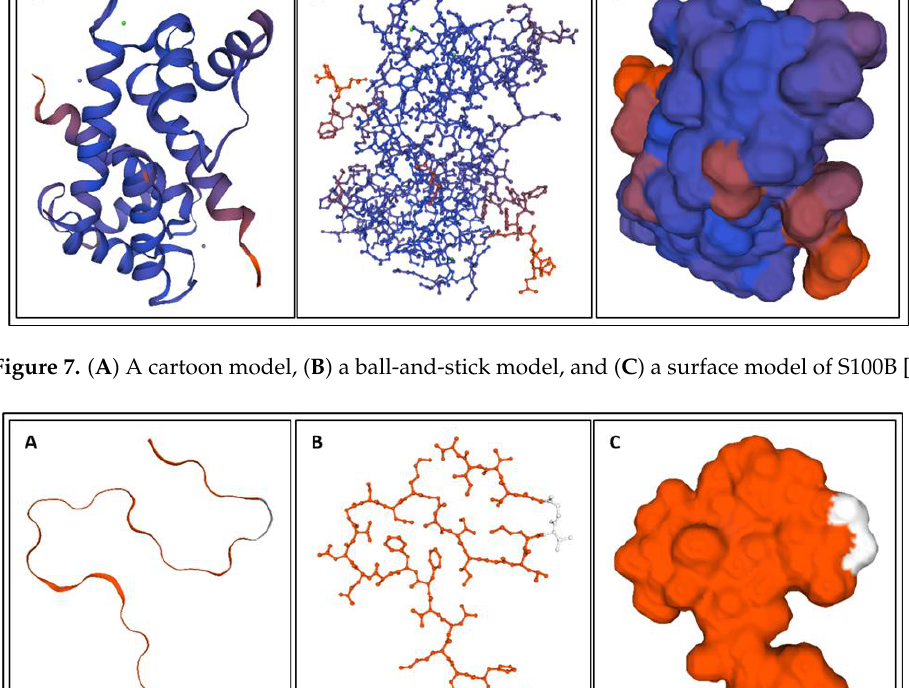
Figure 6. ( A ) A cartoon model, ( B ) a ball-and-stick model, and ( C ) a surface model of tau isoform 0N3R (tau-352) [32].